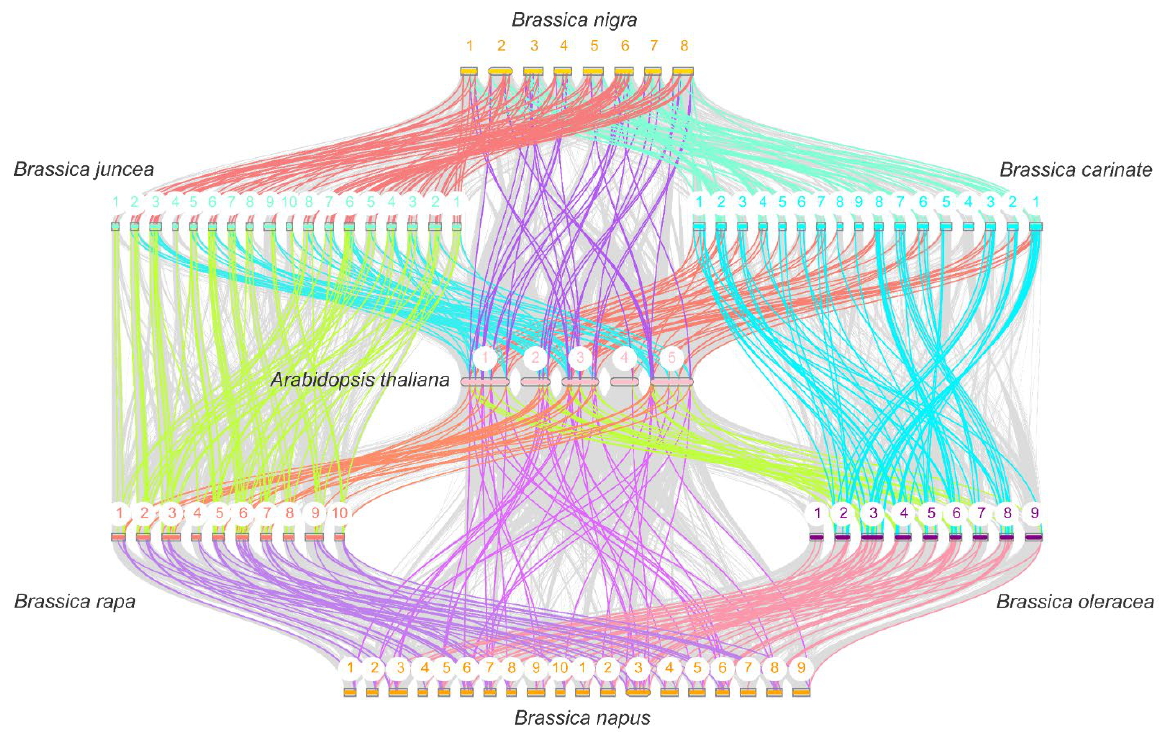
Figure 5. The collinearity analysis of TH genes between Arabidopsis and six Brassica species and between tetraploid and their diploid ancestors. The grey lines in the background indicate the collinear blocks in the genomes of the two species connected by the grey lines, while the colored lines highlight the syntenic TH gene pairs. The colored bars represent the chromosomes of the different species. The chromosome number is labeled at the top of each chromosome.